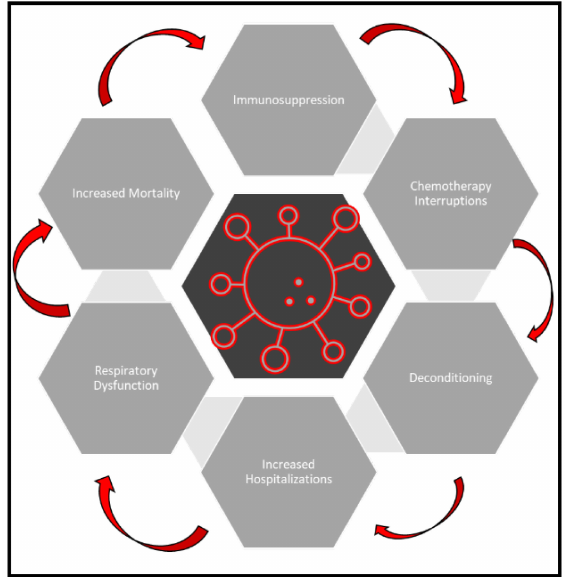
Figure 2. Clinical outcomes of COVID-19 in cancer patients. COVID-19 can cause functional decline, respiratory distress and immunosuppression, which increases risks of hospitalization, chemotherapy interruptions and overall